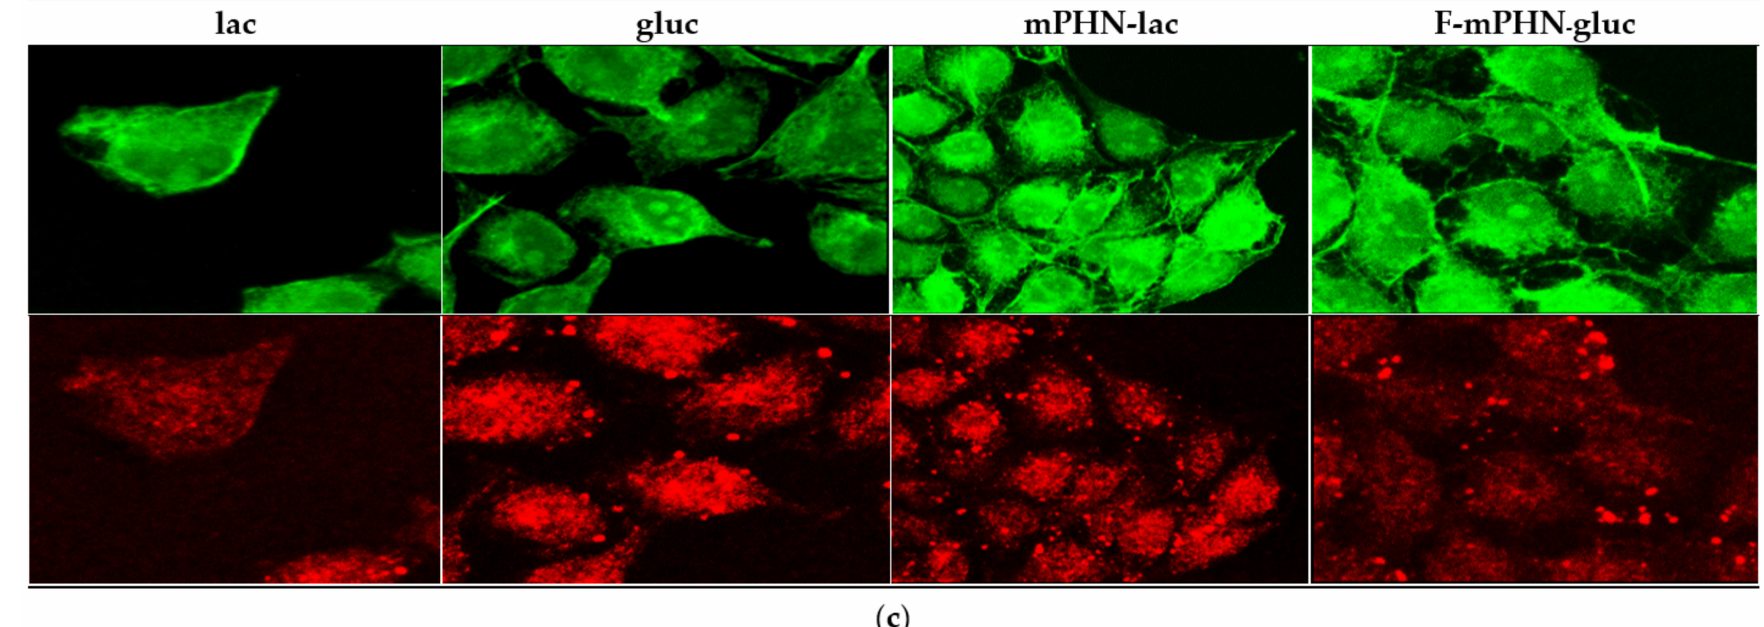
Figure 2. Changes in cytoskeleton of cancer cells visualized with confocal microscopy. Microtubular network—green channel (488 nm); Actin-cytokinoskeleton—red channel (546 nm); intermediate filaments (vimentin)—white channel (excitation—far red 647 nm). Brighter areas (greater density) that can be observed in green channels indicate greater polymerization of microtubules. An increased presence of biodiverse pickling inside the cytoplasm can be seen in red channels suggests an elevated content of depolymerized actin: ( a ) DU145 after 48 h of incubation; ( b ) High resolution images of DU145 after 48 h of incubation; ( c ) High resolution images of HTB140 after 48 h of